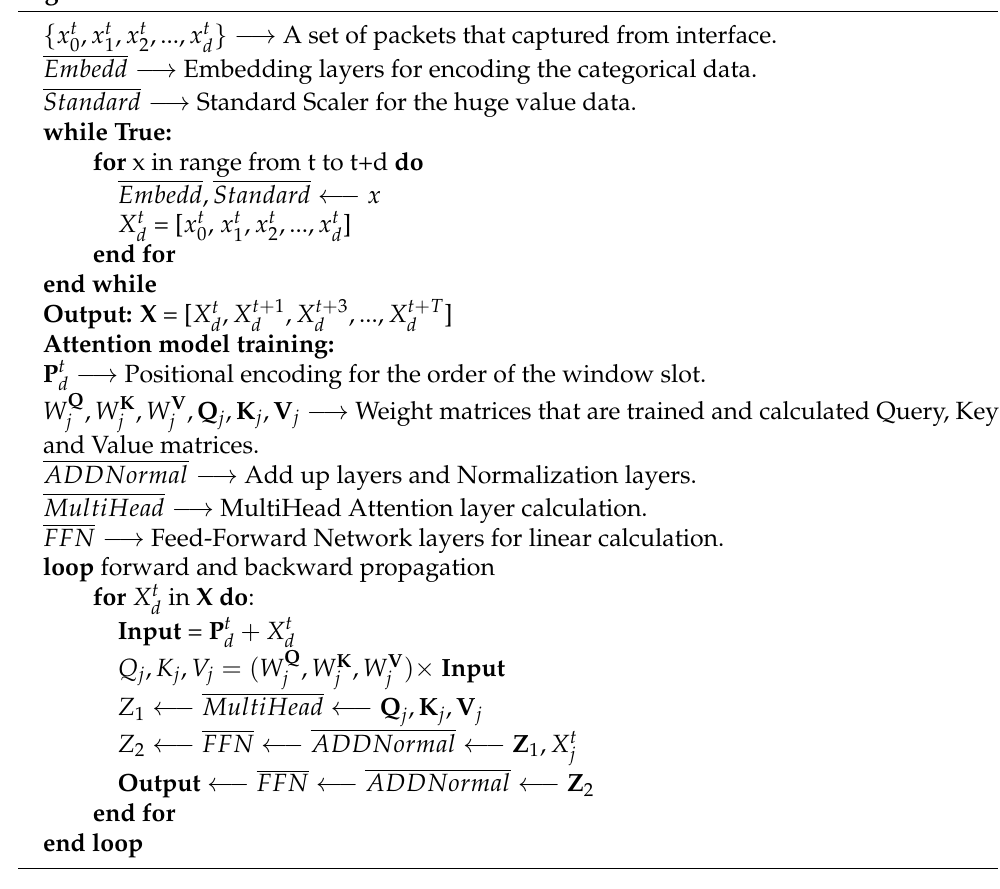
Algorithm 2 Multihead attention network for EDoS attack scheme